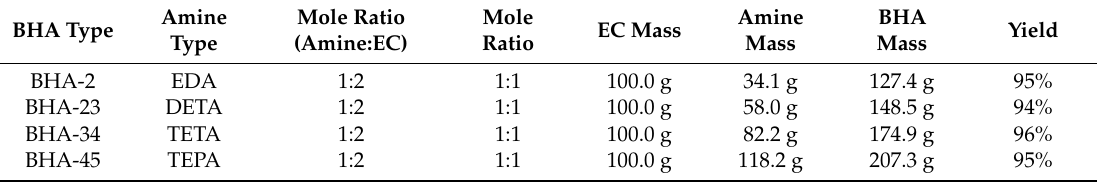
Table 1. The raw materials mass and results of the BHAs. EDA, ethanediamine; DETA, diethylenetriamine; TETA, trethylenetriamine; TEPA, diethylenetriamine; EC, Ethylene